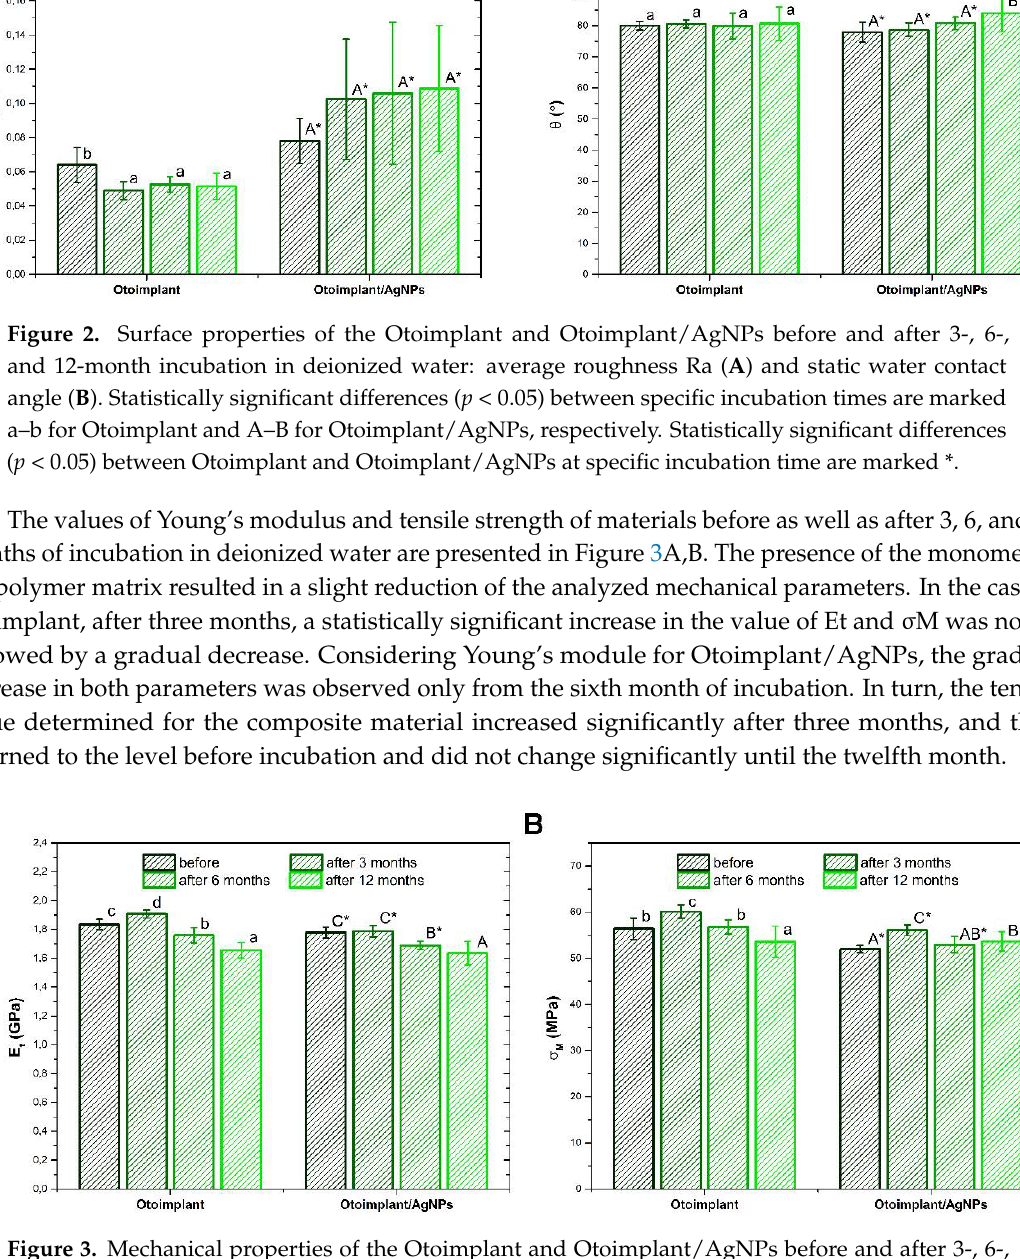
Figure 4. Velocity of longitudinal ultrasonic wave for the Otoimplant and Otoimplant/AgNPs before and after 3-, 6-, and 12-month incubation in deionized water. No statistically significant differences ( p < 0.05) were detected. Changes in the pH and conductivity of deionized water during long-term incubation of the materials are shown in Figure 5A,B. The incubation of both materials resulted in a slight decrease in the pH value of the incubation medium. The same dependence was also noted for the control medium (clean water), the drop was clearly higher. Such results correlated with a slight increase in the conductivity of the medium. The largest changes in both parameters were recorded in the first 30 days of incubation. These changes were related to the dissolution of CO 2 coming from the atmospheric air in the incubation medium during measurements.